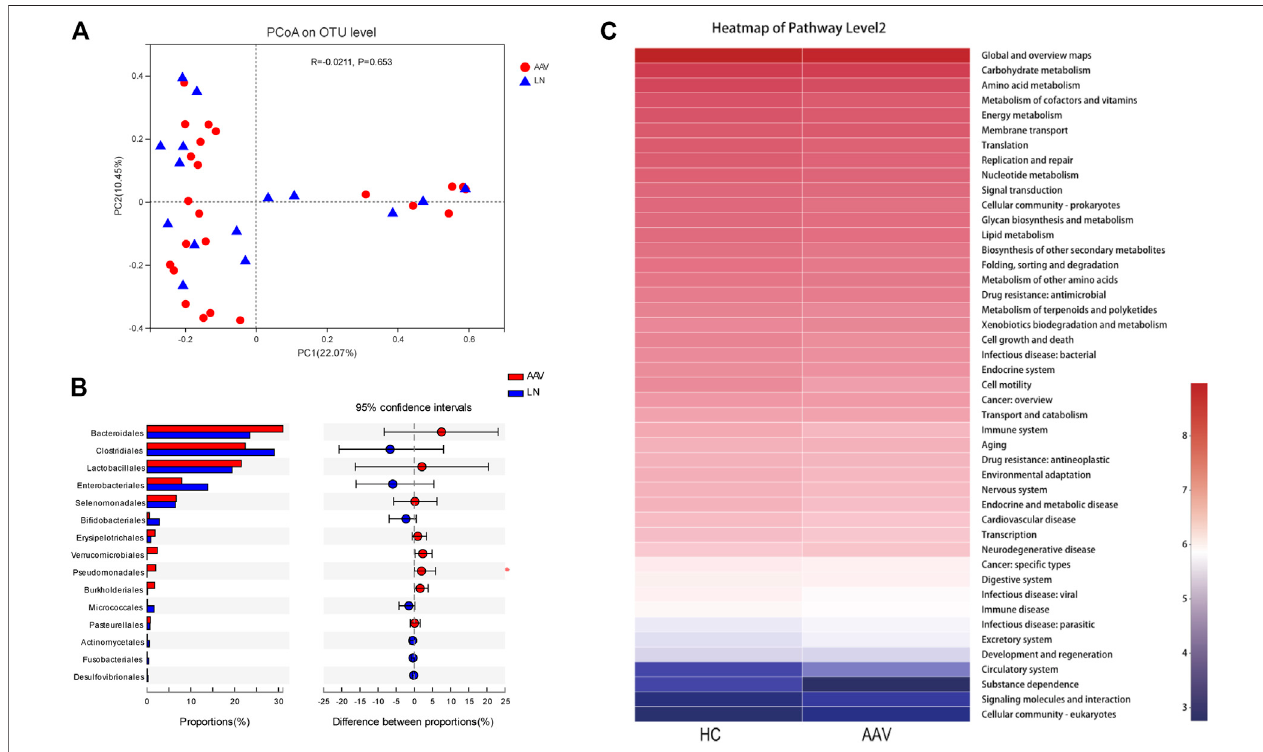
FIGURE4 | Comparing the microbiota composition between the AAV and LN subjects. (A) Beta diversity of gut microbiota showed no obvious signi fi cance between AAV and LN. (B) The proportion of order Pseudomonadales was signi fi cantly higher in samples of AAV than that of LN. (C) Functional prediction of gut microbiota associated with AAV. KEGG categories were obtained from 16s rRNA gene sequences using PICRUSt. * p < 0.05. AAV, ANCA associated vasculitis; LN, lupus nephritis; HC, healthy controls.